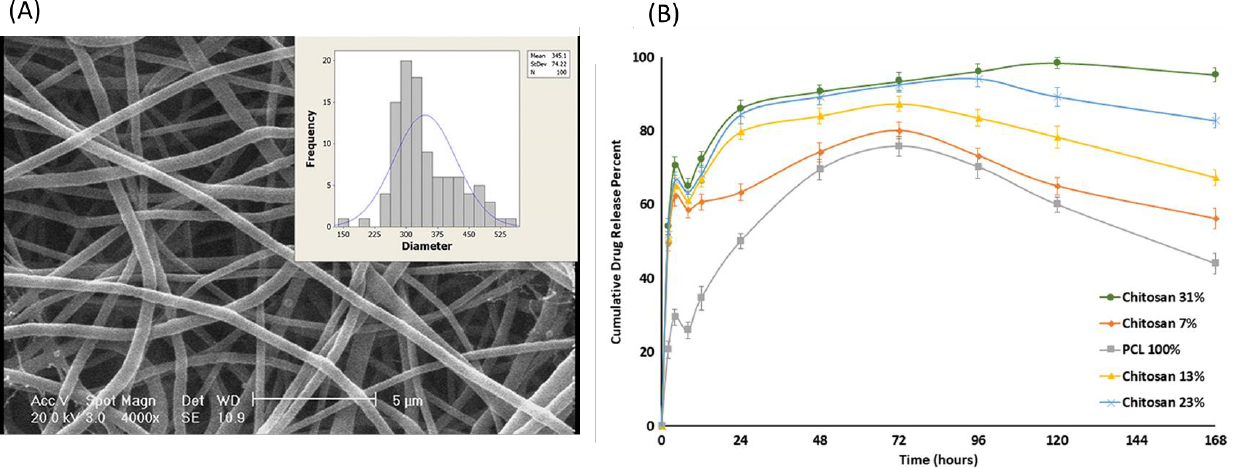
Figure 6. SEM image of nanofibres with ( A ) sub-figure showing a histogram of fibre diameter dis- tribution (scale 5 μm) and ( B ) cumulative release of drug (5-FU) from various nanofibres mat. Re- produced with permission from [78], copyright 2018 John Wiley & Sons, Ltd.